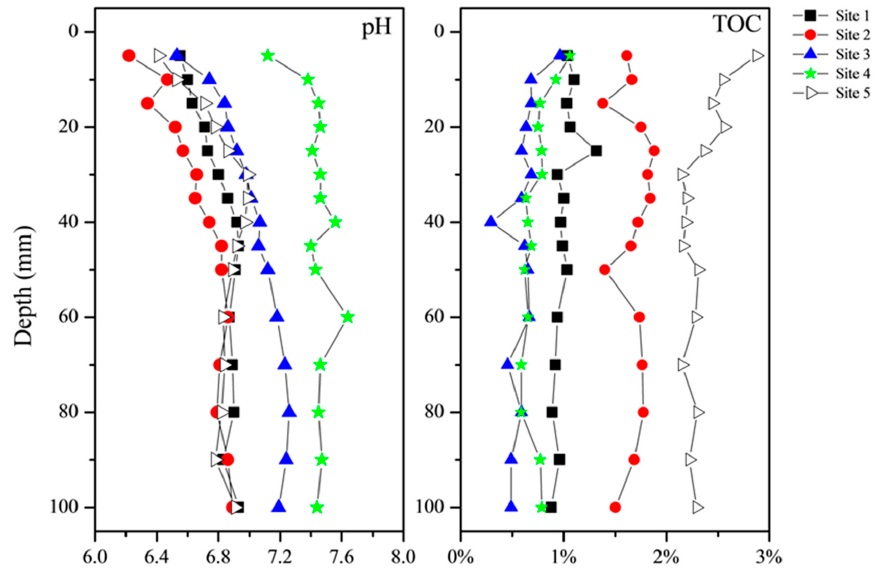
Figure 2. The distribution profiles of pH and TOC in sediments of five sites in Lake Taihu.